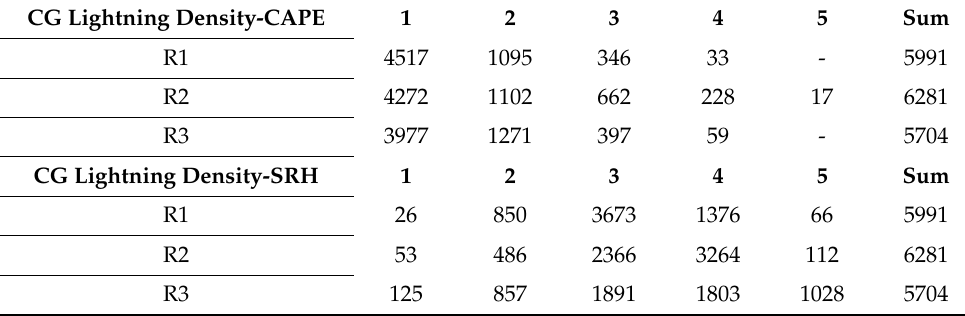
Table A2. The data number in each